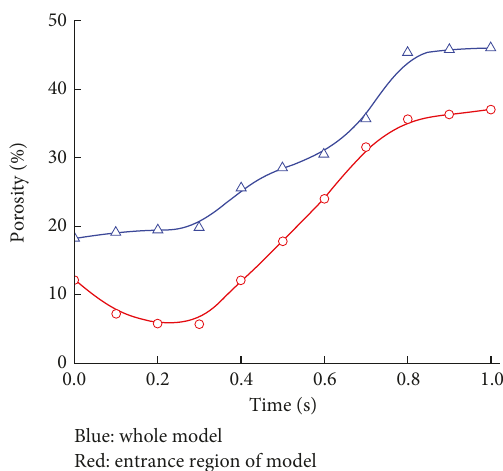
Blue: whole model Red: entrance region of model Figure 11: Variation curve of porosity with